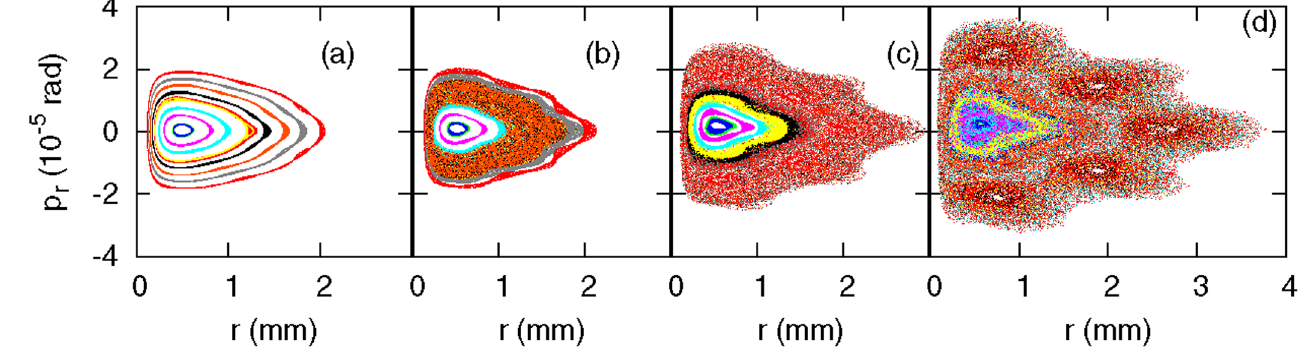
FIG. 5. (Color) Poincare´ plot in r (cid:1) p Particles experience synchrotron oscillation with tune (cid:8)